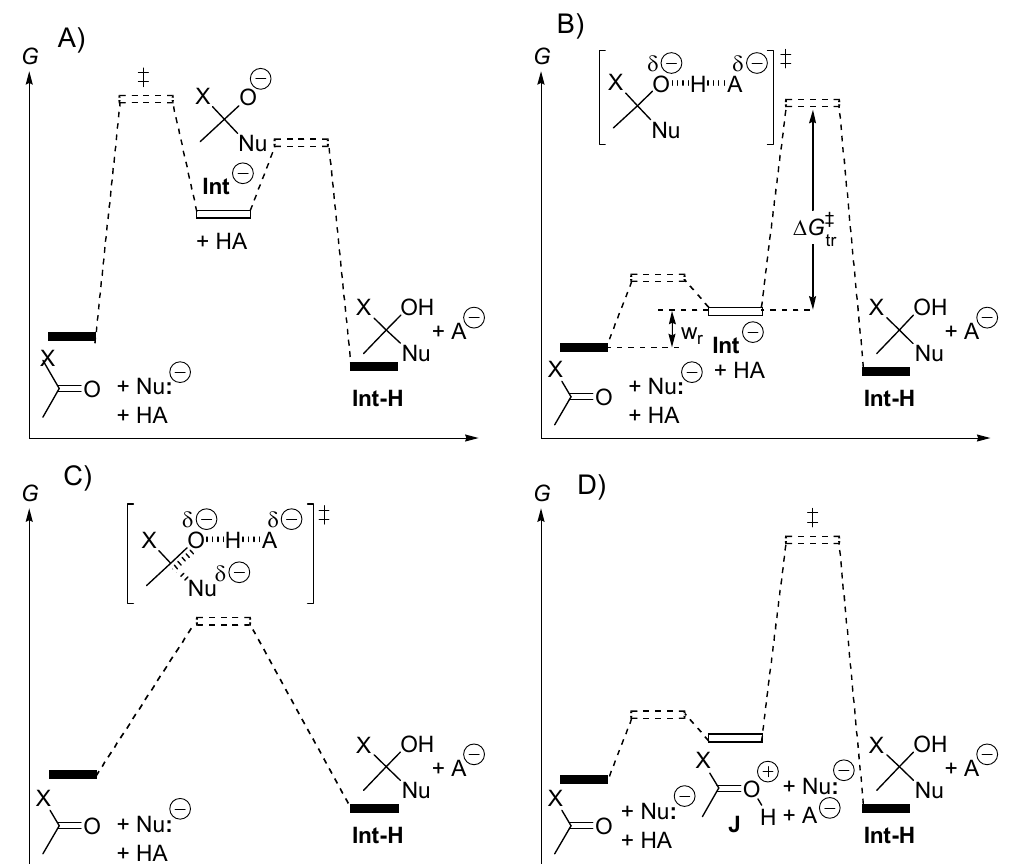
Figure 5. ( A ) The nucleophilic addition is the rate-determining step; ( B ) the proton transfer from the acid catalyst is the rate-determining step; ( C ) the nucleophile addition and proton transfer are concerted; ( D ) the nucleophile addition onto the conjugate acid of the carbonyl compound is